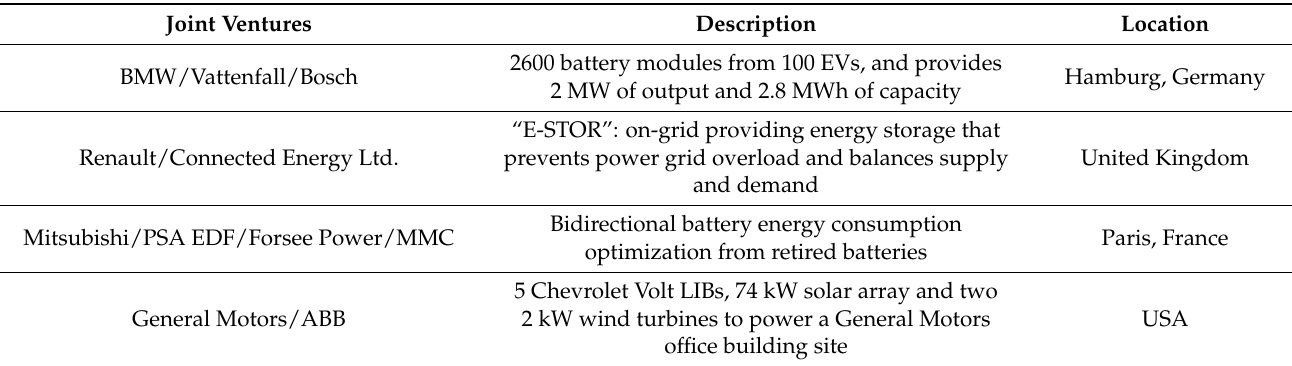
Table 3. Remarkable second life batteries projects